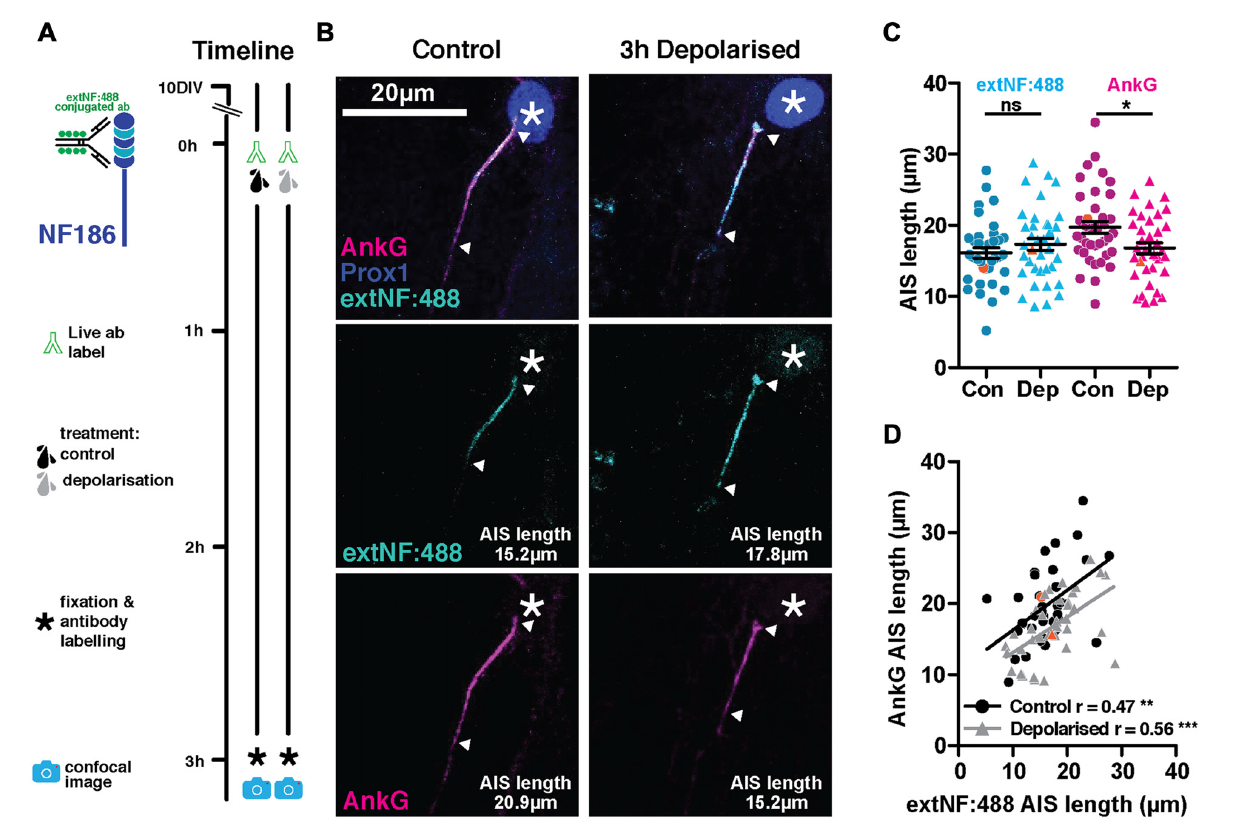
FIGURE 3 | ExtNF antibody conjugated with Alexa-488 does not track AIS plasticity. (A) Diagram of AIS live label method used and experimental timeline. (B) Maximum intensity projections of example neurons labeled live with the extNF antibody conjugated to Alexa-488, after which they were subjected to either a 3 h control or depolarization treatment. Following fixation, cells were stained with antibodies against AnkG (magenta) and Prox1 (dark blue). Asterisks, nucleus; arrowheads, DGC AIS start and end positions. (C) Distributions of AIS lengths measured with extNF-488 conjugated antibody and AnkG from control or depolarized DGCs. Each dot or triangle represents a single cell; orange symbols, values from example cells displayed in (B) ; dark lines show mean ± SEM; Bonferroni post-test after two-way repeated measures ANOVA; ns, non-significant; ∗ p < 0.05. (D) Correlation analysis for AISs labeled with both the extNF-488 conjugated antibody label and AnkG under control or depolarized conditions. Orange symbols, values from example cells displayed in (B) ; lines show best linear regression fit for control (black) or depolarized cells (gray); ∗∗ p < 0.01; ∗∗∗ p < 0.001.